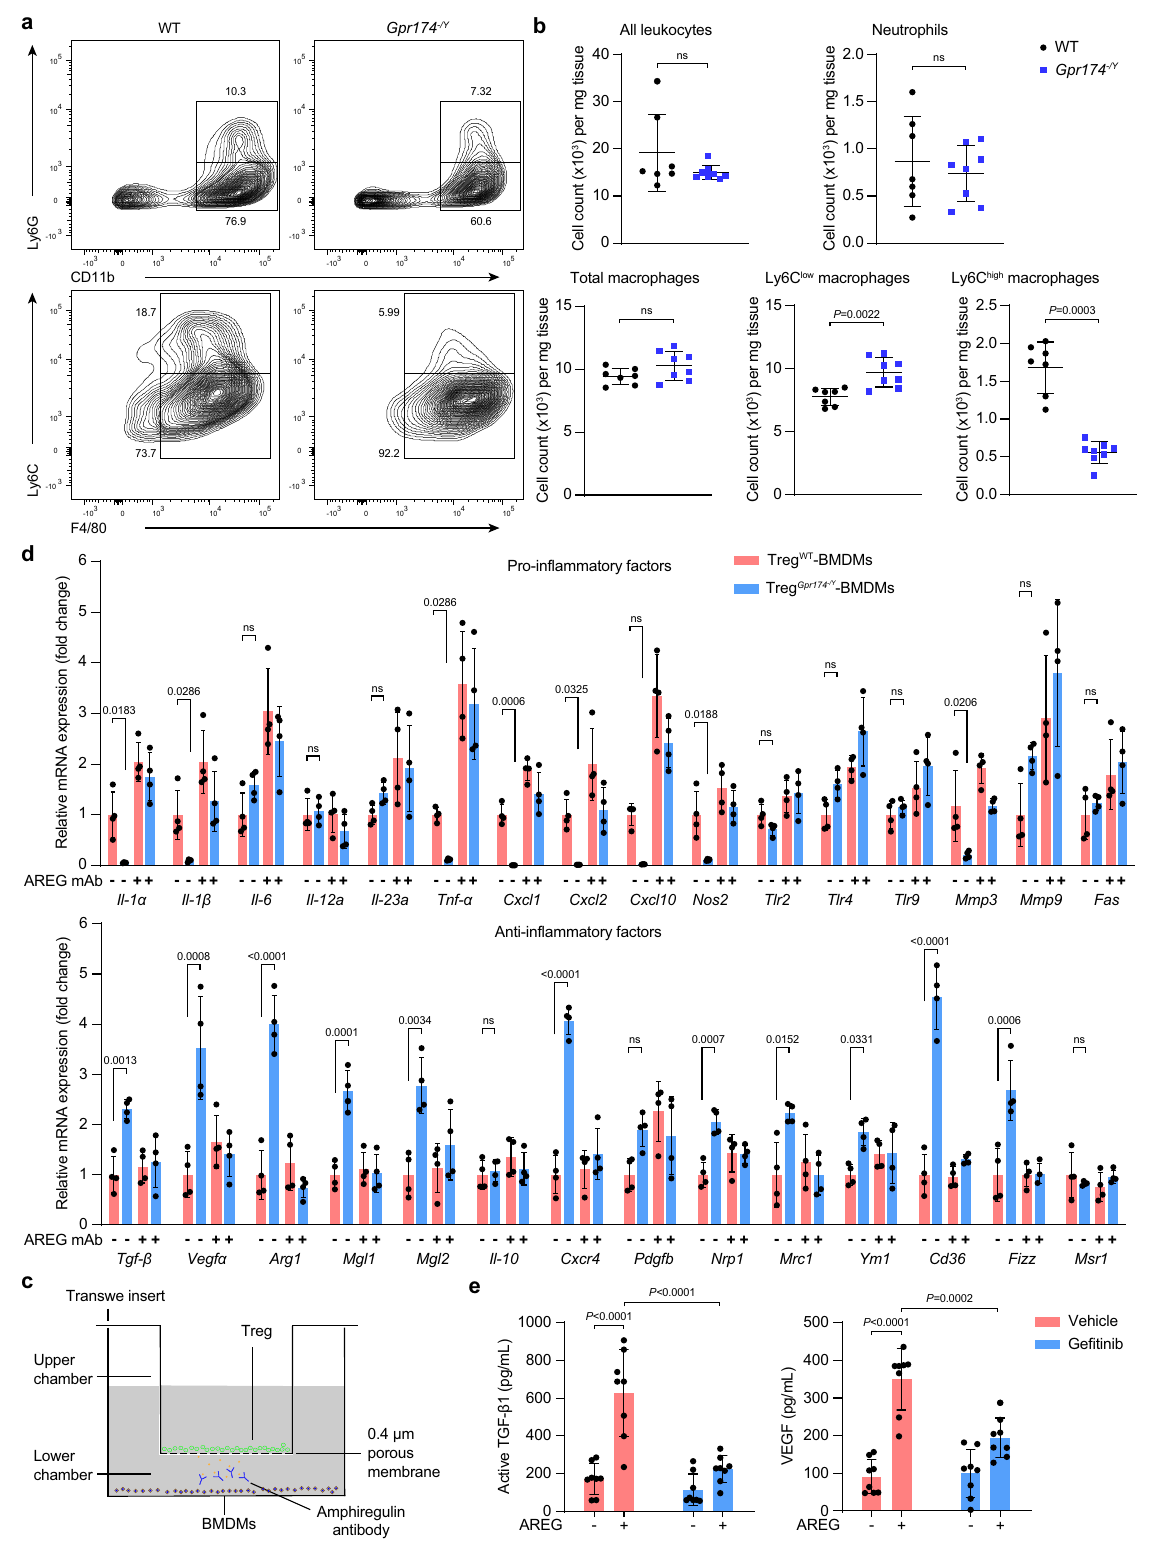
Fig. 5 | GPR174 de fi ciency mitigates the in fl ammation in ischemic muscles through AREG. a Representative fl ow cytometric dot plots of leukocyte popula- tions in gastrocnemius tissues of WT and Gpr174 − /Y mice 7 days after HLI. b Quanti fi cation of all leukocytes, neutrophils, total macrophages, Ly6C low macro- phages, and Ly6C high macrophages in WT and GPR174-de fi cient gastrocnemius 7 days post HLI ( n =7 for WT mice; n =8 for Gpr174 − /Y mice). c Scheme of Tregs- macrophagesco-culture. d RelativemRNAlevelsofproin fl ammatory(upperpanel)